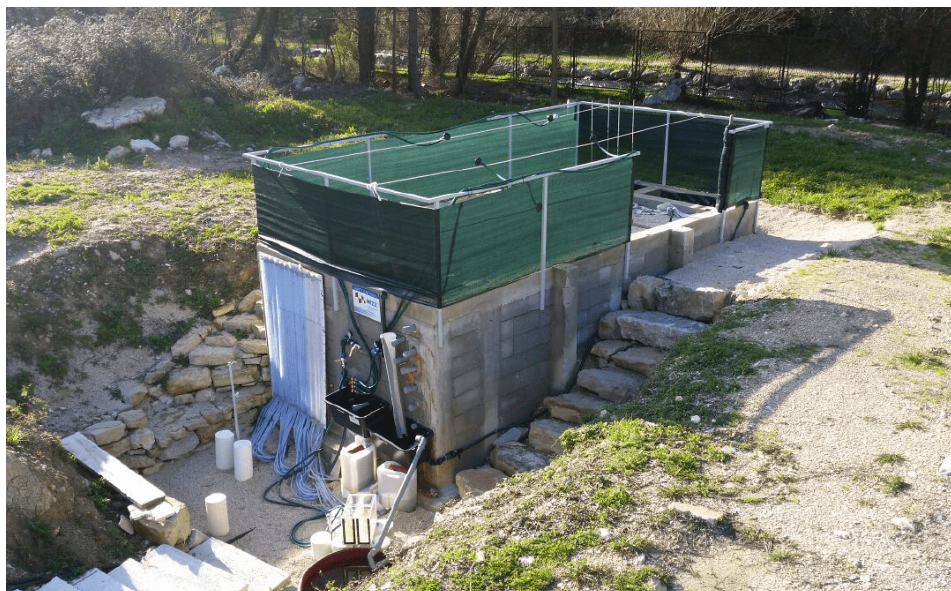
Figure 6. Photograph of the physical model.